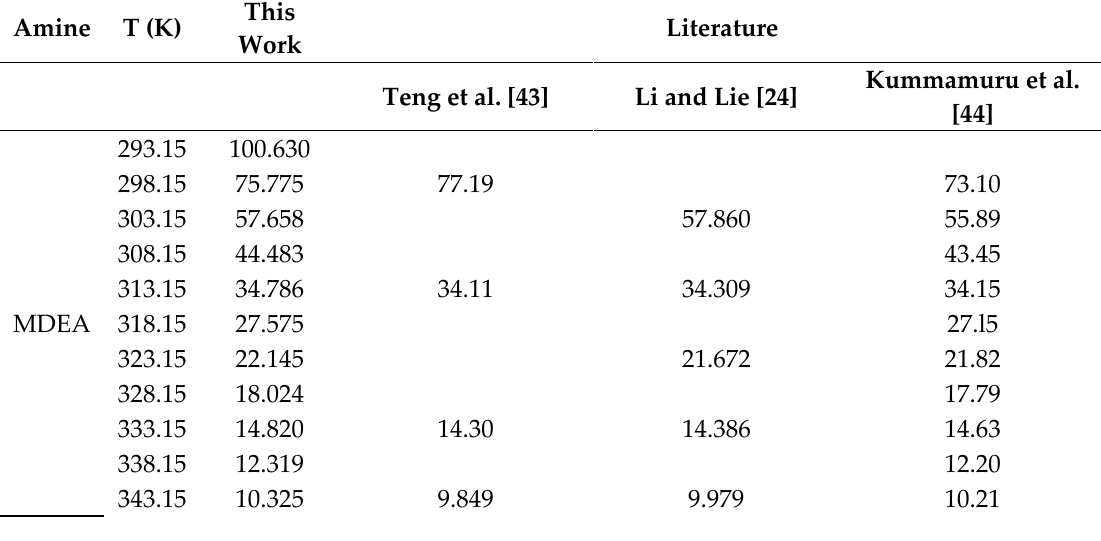
Table 10. Viscosities 𝜂 (mPa · s) of pure amines MDEA, DMEA, and